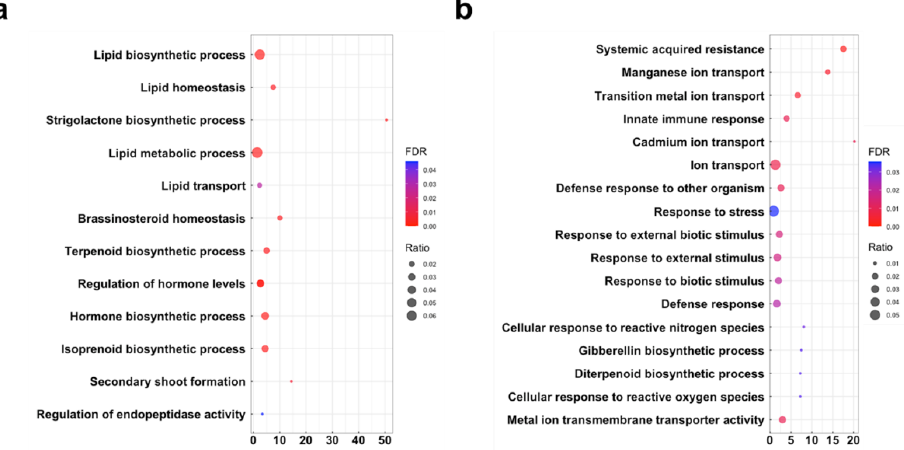
Figure 4. Gene ontology (GO) enrichment analysis on AM-upregulated genes. ( a ) GO terms enriched in the upregulated DEGs shared between tomato roots colonized by Rhizophagus irregularis or Gigaspora margarita . ( b ) GO terms enriched in DEGs upregulated only in roots infected by G. margarita. The representative GO terms obtained from the tested DEGs are listed. Bigger circles in the hierarchical clustering trees represent more genes annotated to the respective GO terms. The right-hand color bars indicate p values (< 0.05). Detailed information is presented in Table S3.